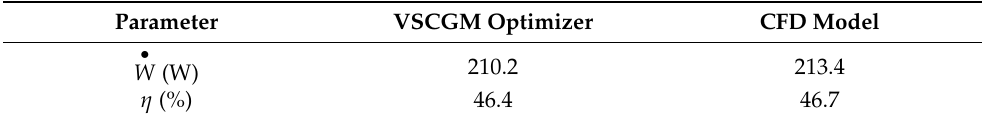
Table 5. Verification of the optimal solution for the baseline case.